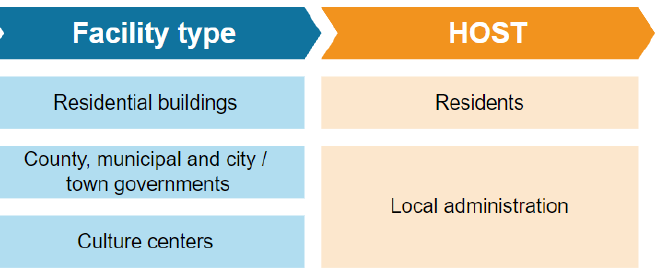
Figure 3. An example of assigning object types to hosts. Source: the authors’ own study.